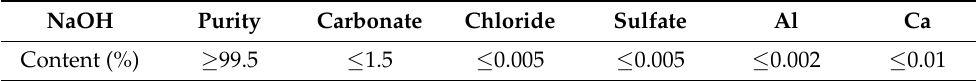
Table 3. Technical index of NaOH (analytical purity).